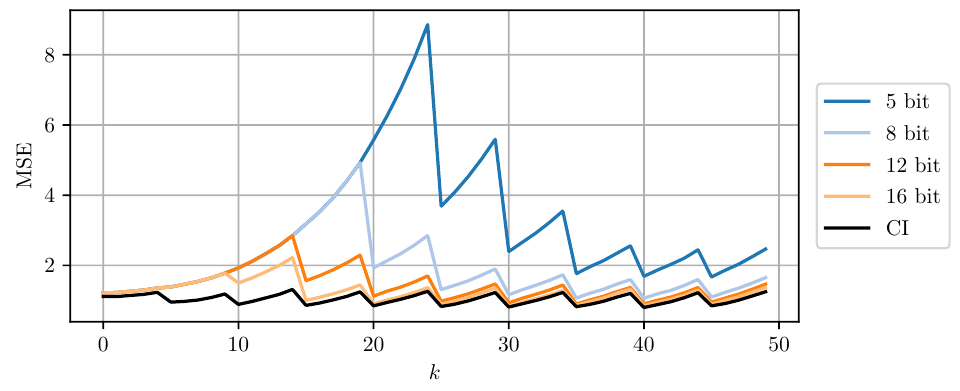
Figure 9. The estimate MSE of sensor node b plotted over time step k for varying bits per codeword using MC-CI. ‘CI’ indicates the use of a 64 bit floating point representation for each